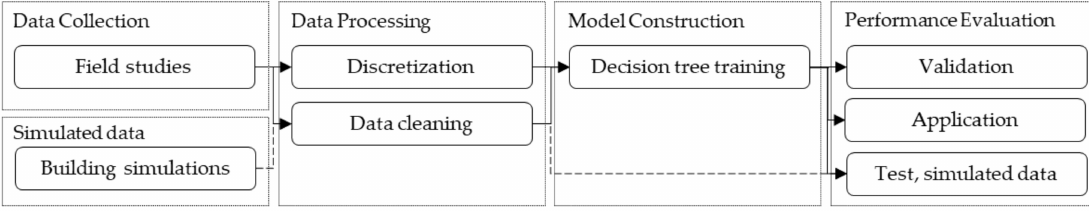
Figure 1. Process map of the methodology applied in this study. The data collected from field studies is represented with a solid line, whereas the simulated data is illustrated with a dashed